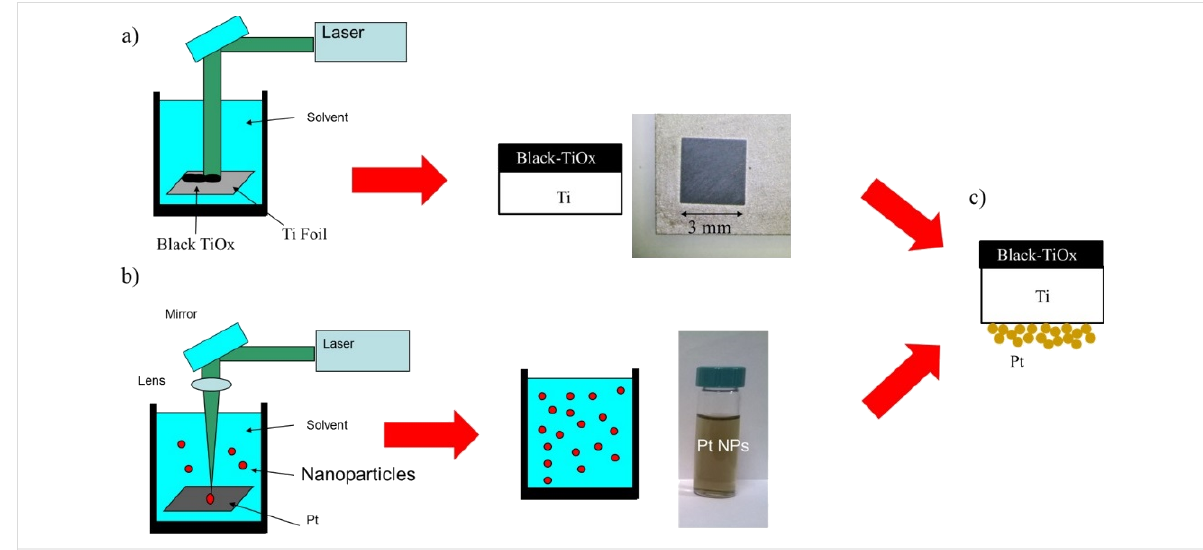
Figure 1: Schematic representation of the sample preparation steps: (a) laser irradiation of the Ti foil in order to form the black TiO x layer; (b) synthesis of Pt nanoparticles via laser ablation in water; (c) schematic representation of the black TiO x /Ti/PtNp multilayer structure after the depo- sition of the Pt nanoparticles on the rear side of the irradiated Ti